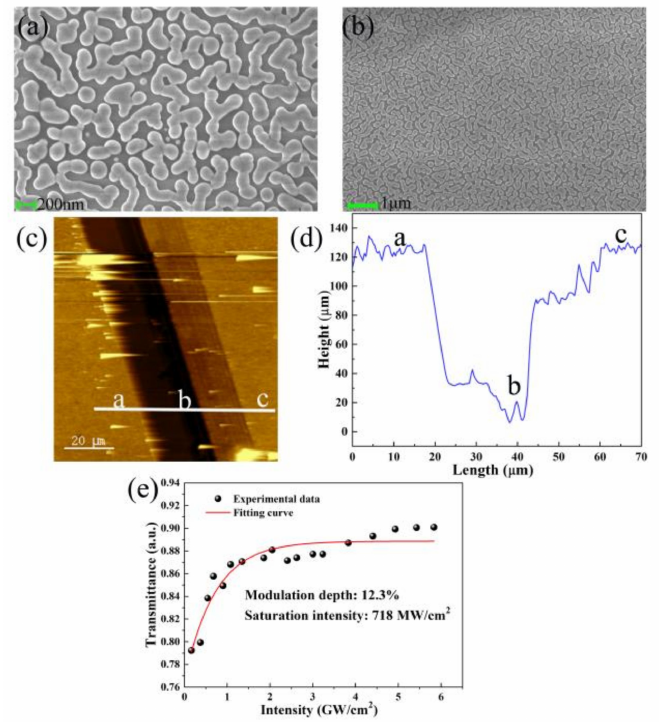
Figure 1. Characterizations of Mo:BiVO 4 nanoparticles dispersion and nonlinear transmission: ( a ) the SEM with a 200 nm scale; ( b ) the SEM with a 1 µ m scale; ( c ) the atomic force microscopy (AFM) image, where position b is the area with no film, and positions a and c are the areas with film; ( d ) the height of the Mo:BiVO 4 nanoparticles; ( e ) the nonlinear